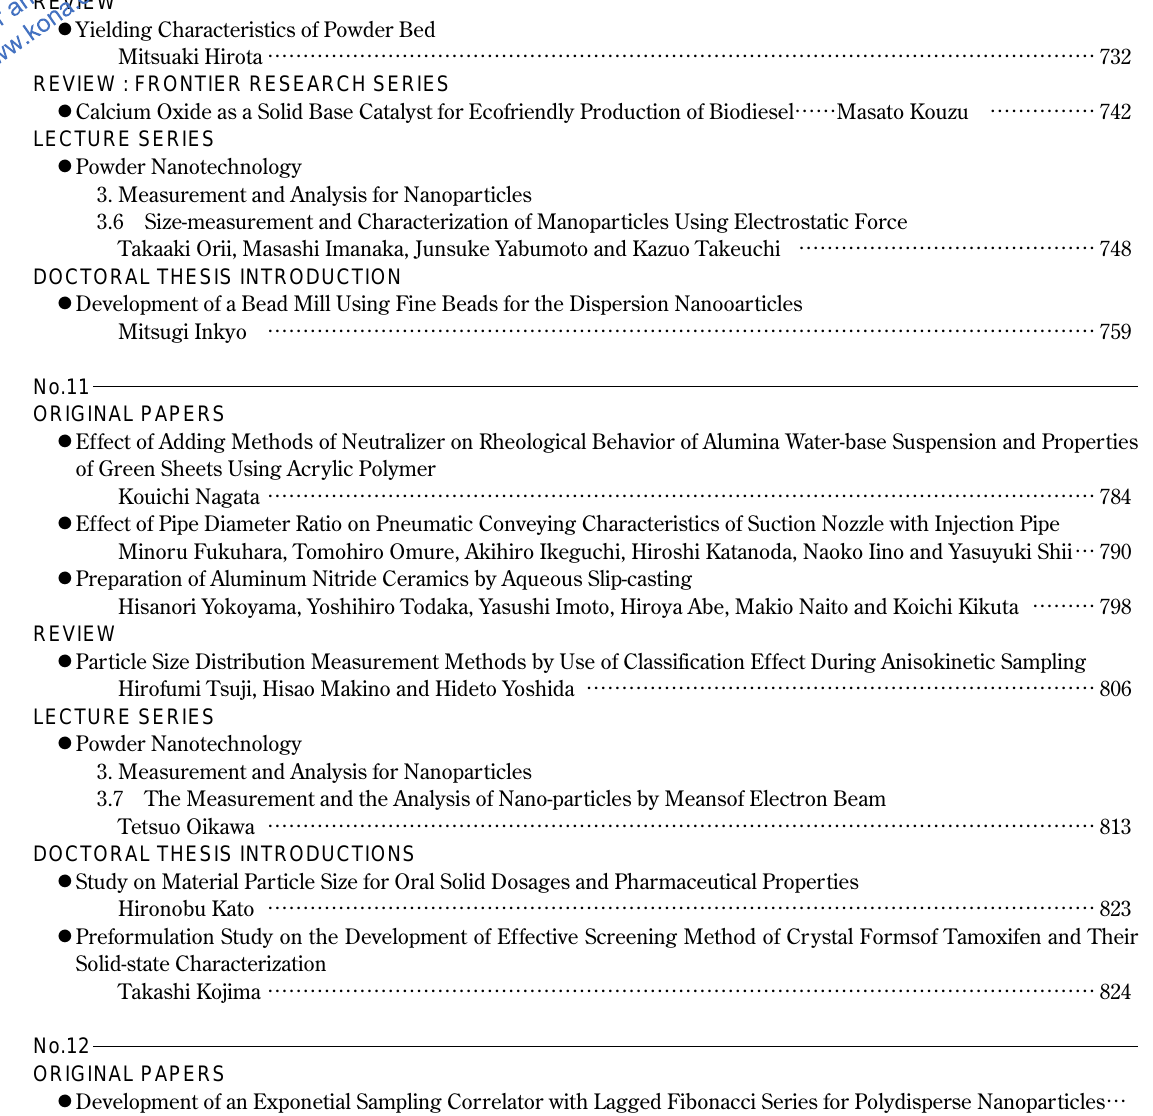
・ Classification Characteristics of Backward Sampling and Its Application to Particle Size Distribution